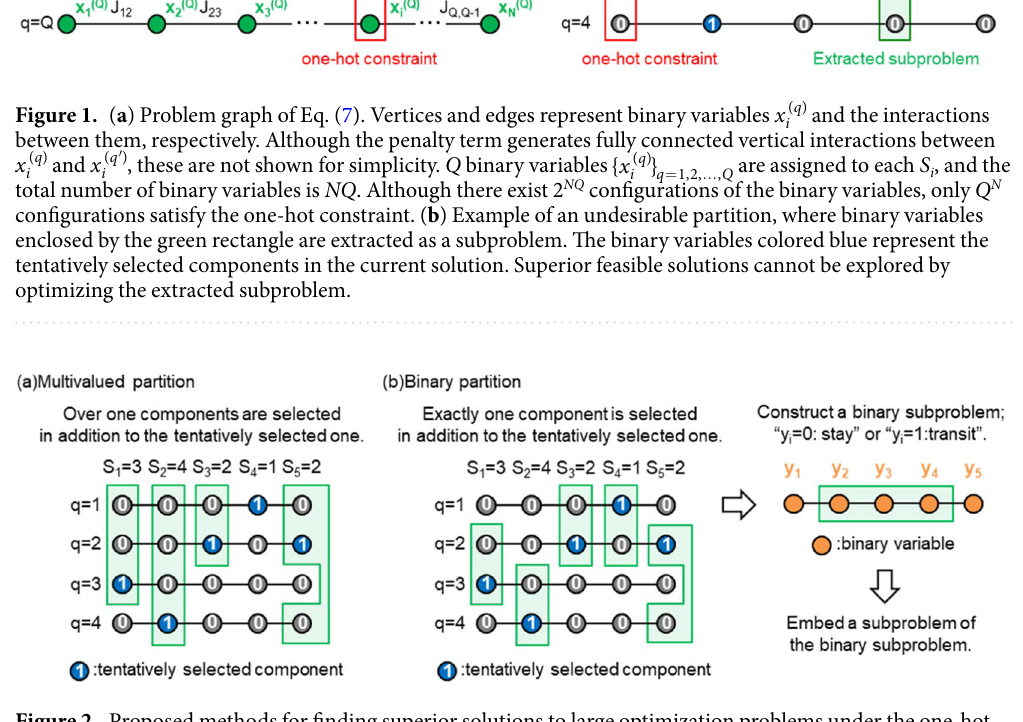
q ( ) and the interactions i